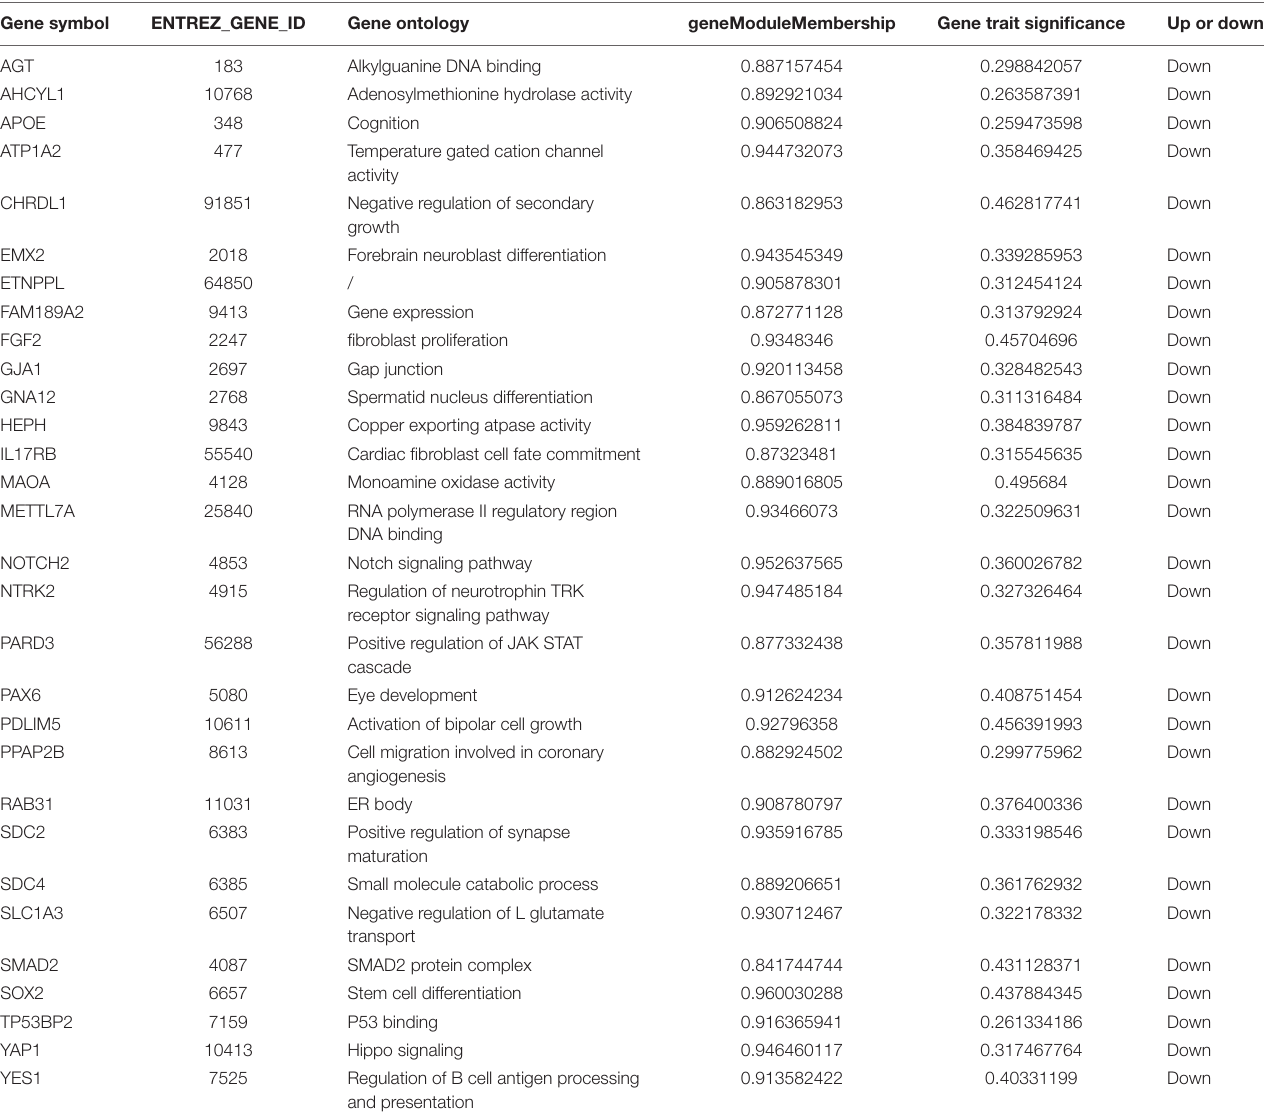
TABLE 1 | Hub genes from the interesting